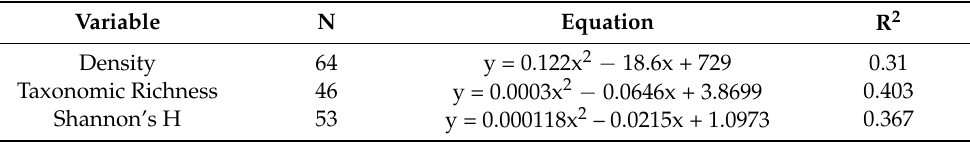
Table 2. Polynomial regression fits to benthic organism density, species richness, and diversity (Shannon–Wiener) versus % stamp sand (all are p < 0.001).